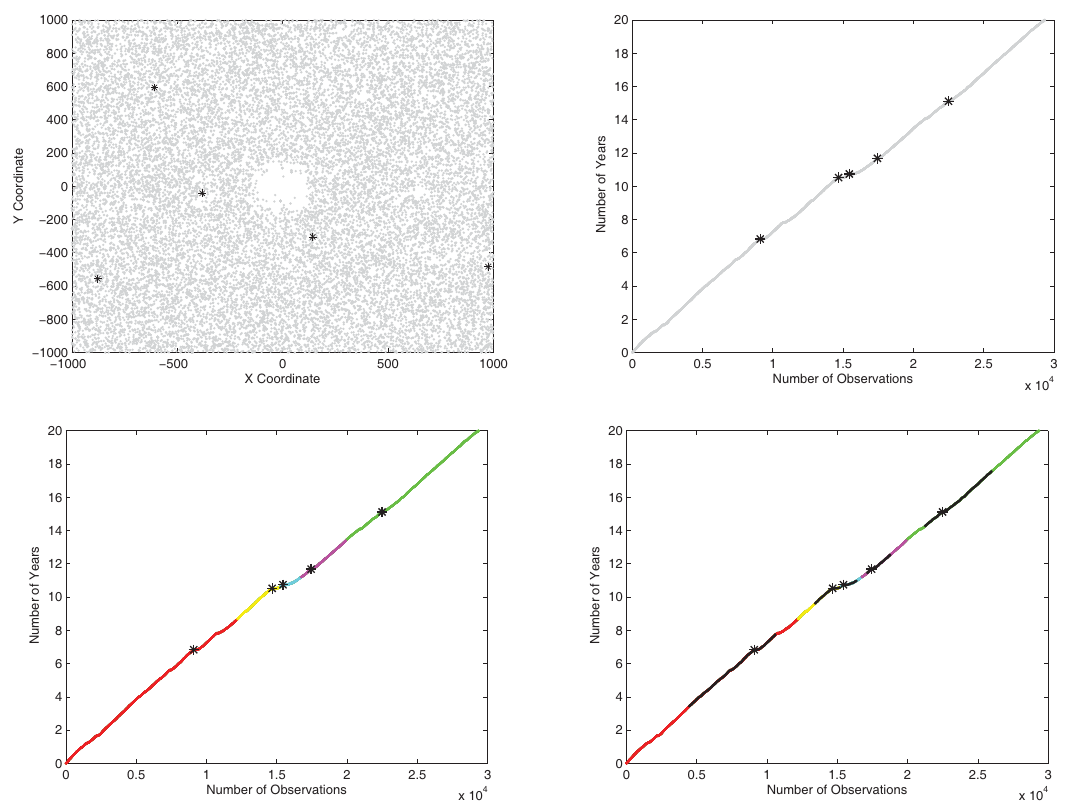
Fig. 3. Tri-stage cluster identification analysis for the synthetic seismic catalog, (top left) locations of all events coordinate in light grey and mainshocks shown in black, (top right) locations of mainshocks w.r.t. time , (bottom left) output of temporal clustering, (bottom right) output of time zone clustering (black solid lines representing duration of clustered time zone). Note the quiescent region at the center of the catalog (top left). This area and its surroundings (see exact extent in Mignan and Tiampo, 2010) include spatiotemporal variations in the seismicity rate, corresponding to a cycle of quiescence-activation (or accelerating seismic release pattern).